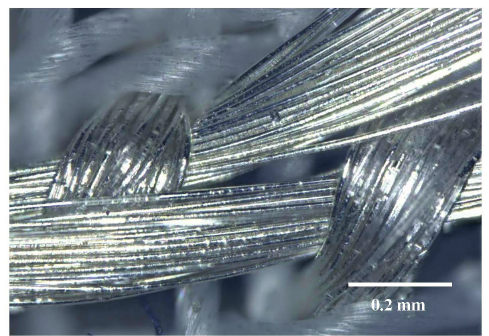
Figure 1. Detail of the embroidered electrode made from Ag/Ti-coated PET yarn.